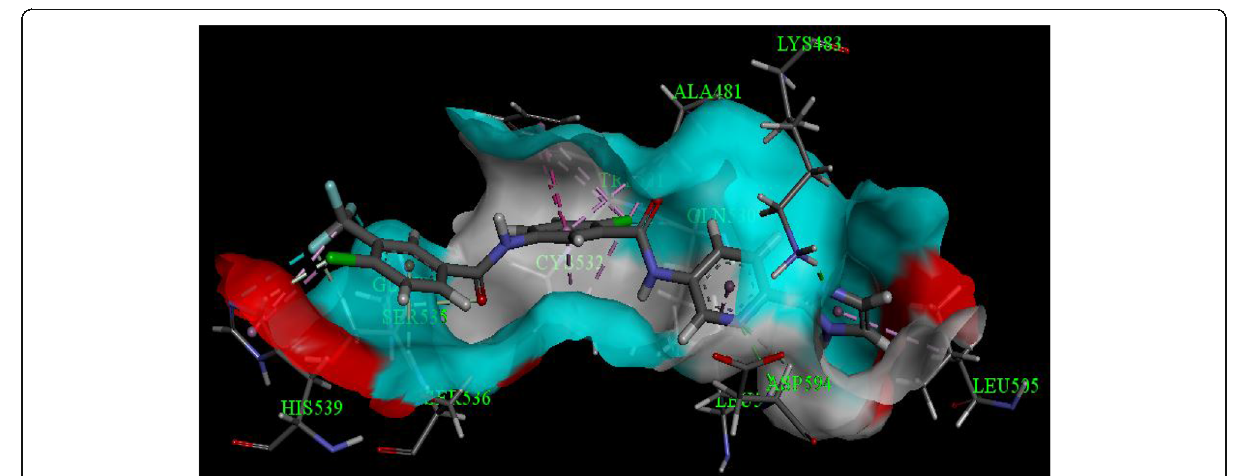
Fig. 1 3D diagram for the interaction of compound 14 with